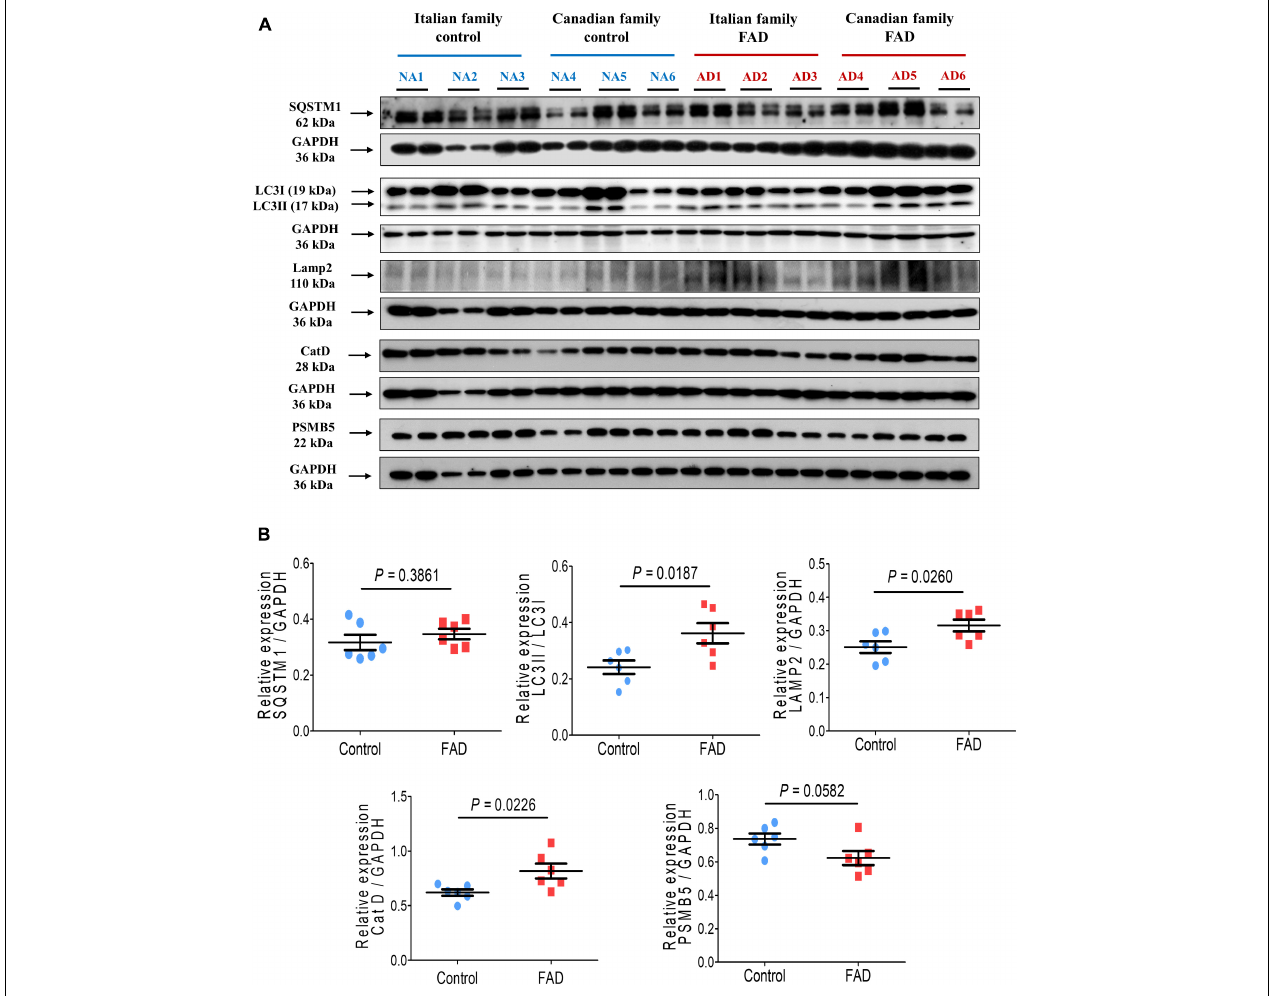
FIGURE 2 | Immunodetection of autophagy (SQSTM1 and LC3II), lysosomal (LAMP2 and CatD) and proteasomal (PSMB5) markers in fibroblasts from FAD individuals and control subjects (NA). Proteins were evaluated by Western blotting. (A) Blots for fibroblast protein extracts from control (6) and FAD (6) individuals. Samples were analyzed in duplicate. (B) Analysis of SQSTM1, LC3II/LC3I, LAMP2, CatD and PSMB5. Protein levels were normalized to GADPH in the sample. The points on the graphs represent the average value of duplicates for each sample. Statistical analysis in (B) was performed with Student’s t -test.